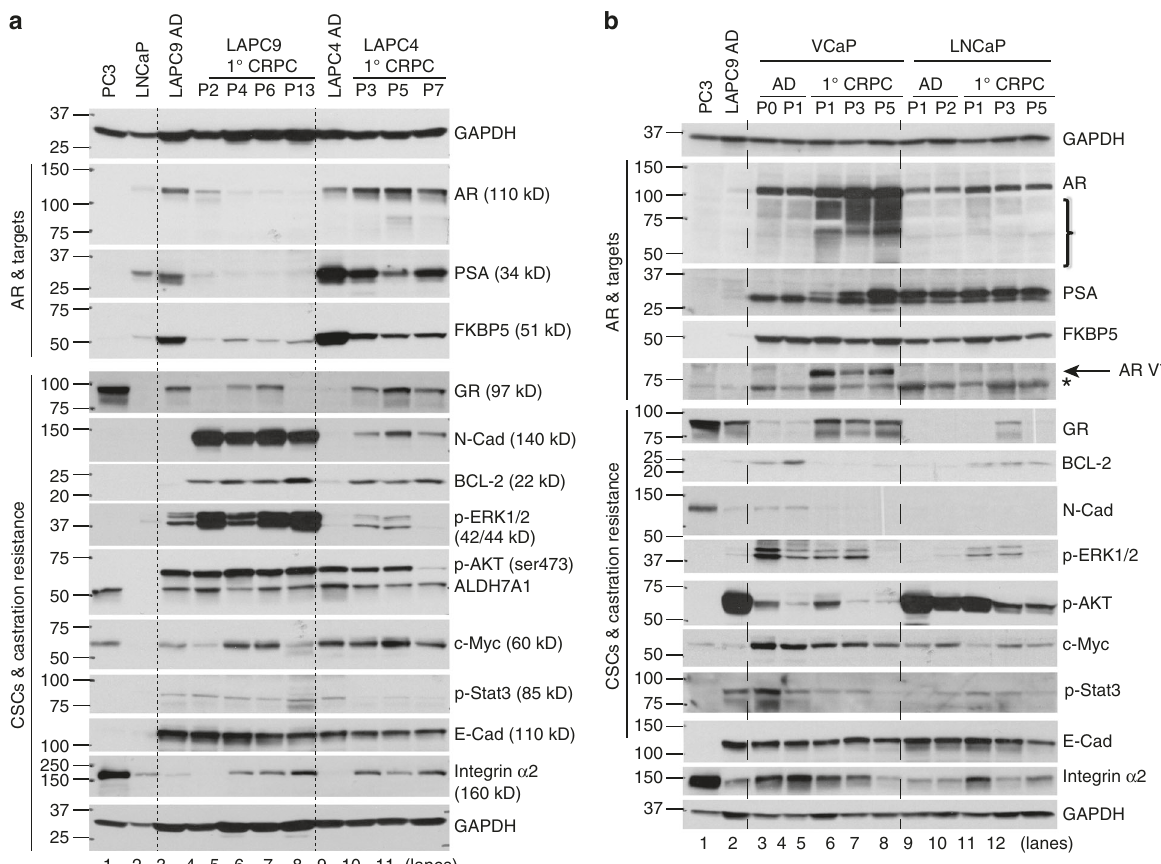
Fig. 2 Four primary (1°) CRPC exhibit distinct changes in AR and other molecules. Four xenograft models were serially passaged in castrated male NOD/ SCID (for LAPC9 and LAPC4; a or NOD/SCID- γ (NSG; for LNCaP and VCaP; b mice. The CRPC (passages indicated) and their corresponding AD tumors were harvested for WB analysis of indicated “ AR and targets ” and “ CSCs and castration resistance ” molecules (for AR, the clone 441 mouse mAb was used; Supplementary Table 1). PC3 cells were used as negative controls for AR. For each sample, whole cell lysate (60 μ g) was loaded each lane, and GAPDH served as loading controls (top and bottom lanes). In a, no AR-V7 was detected in either LAPC9 or LAPC4 models. In b, the bands below AR indicated by a bracket are likely AR variants. *a non-speci fi c